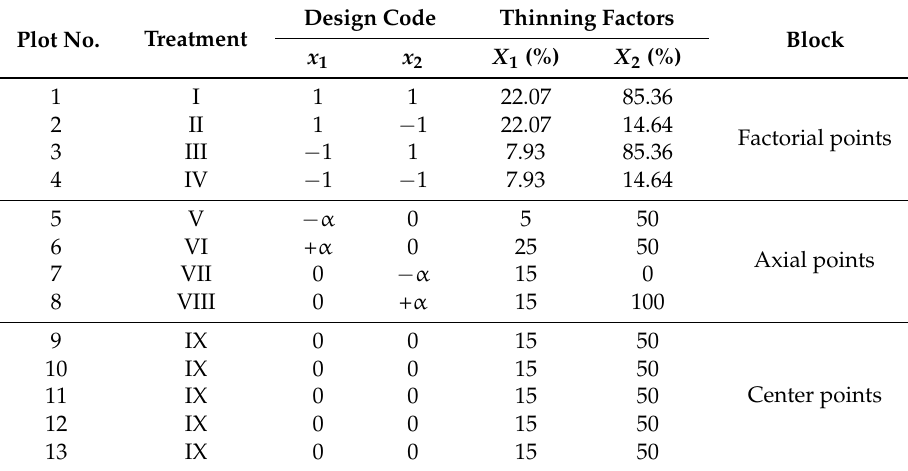
Table 3. Experiment design runs in DPS